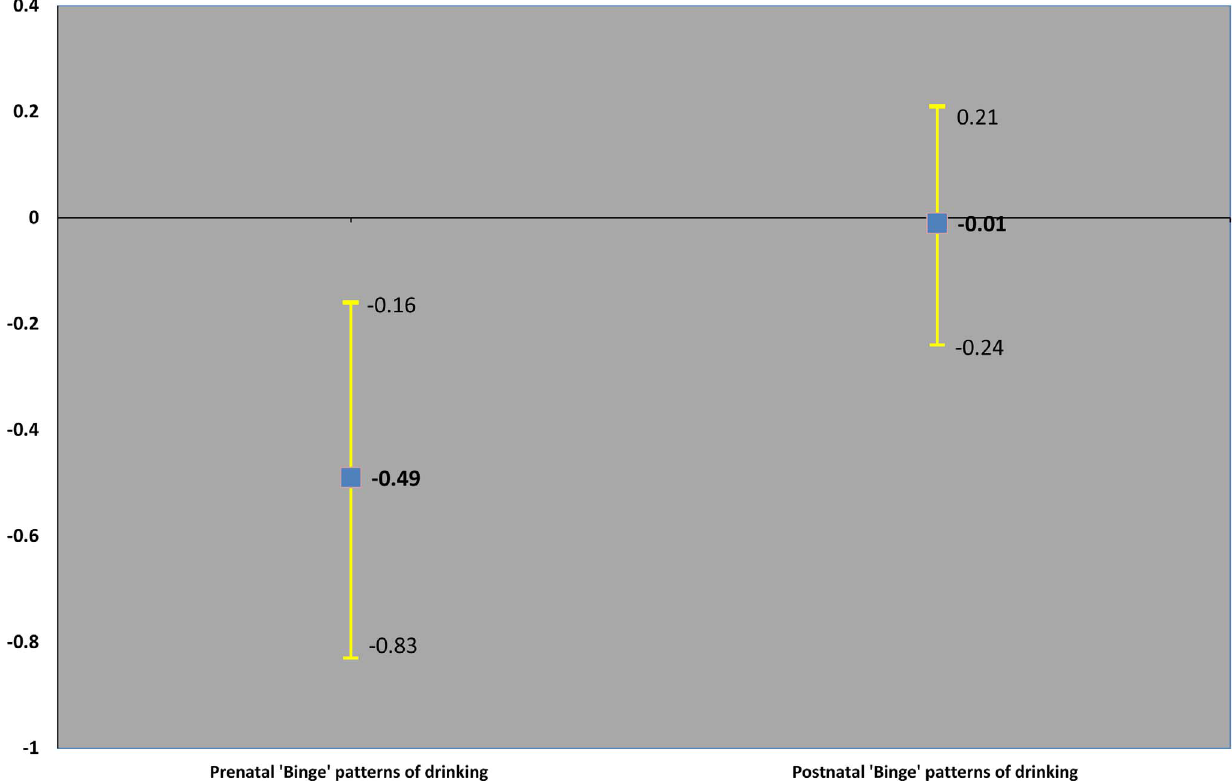
Figure 2. Mean change in offspring KS2 score per increase in maternal alcohol categories during and after pregnancy. Adjusted for sex, maternal age, parity, socio-economic position, ethnicity, maternal and paternal education and smoking and other parent’s alcohol consumption.